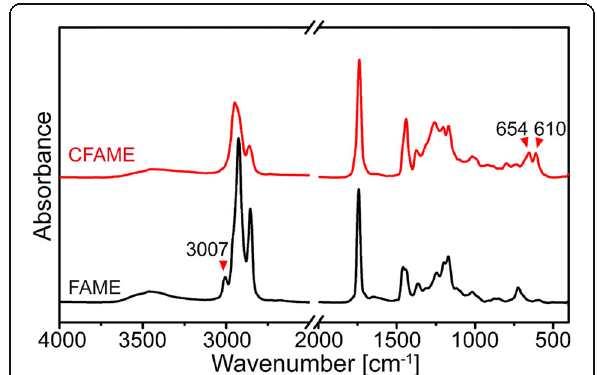
Fig. 2 FT-IR spectra of CFAME and FAME